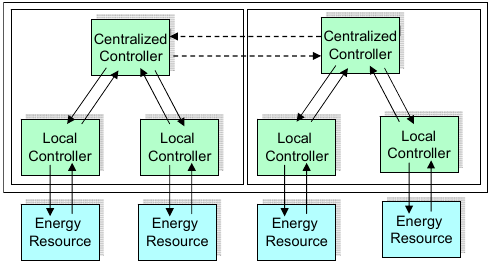
Figure 3. Illustration of a hybrid centralized and distributed control scheme.